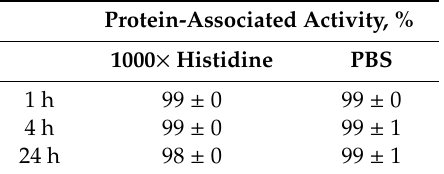
Table 2. In vitro stability of [ 99m Tc]Tc(CO) 3 -Ec1.